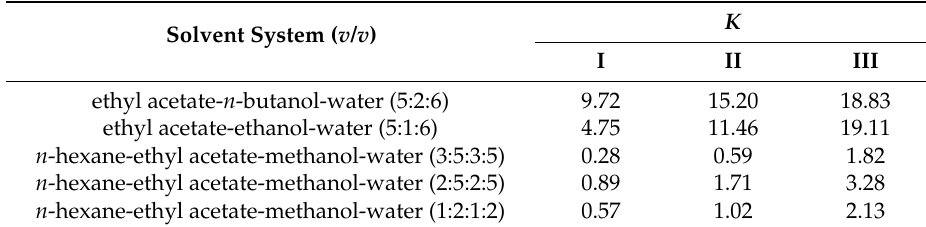
Table 1. The K values of the target compounds in several solvent system.